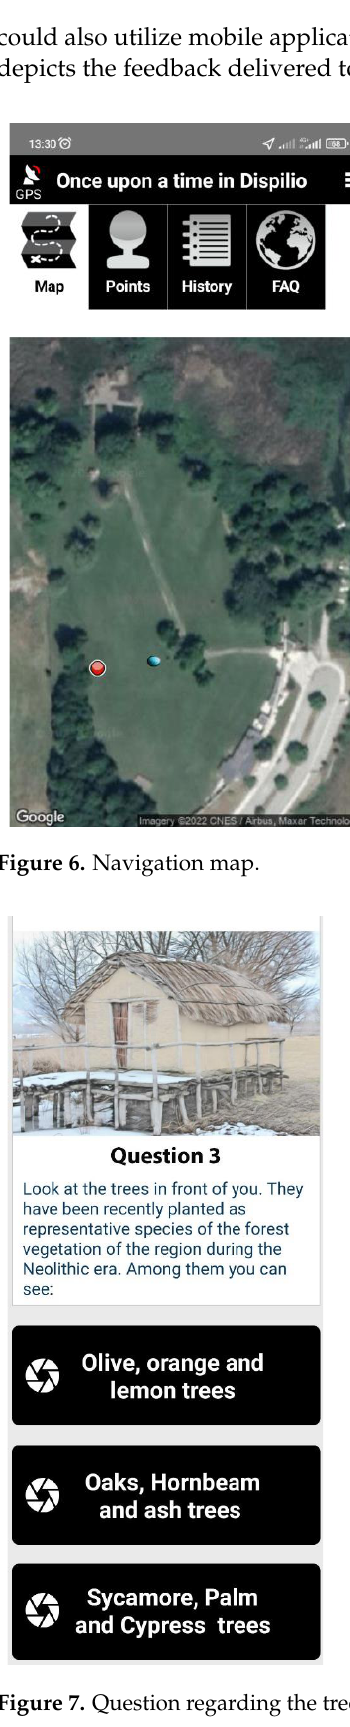
Figure 8. Feedback given to the users after they answer question 3.